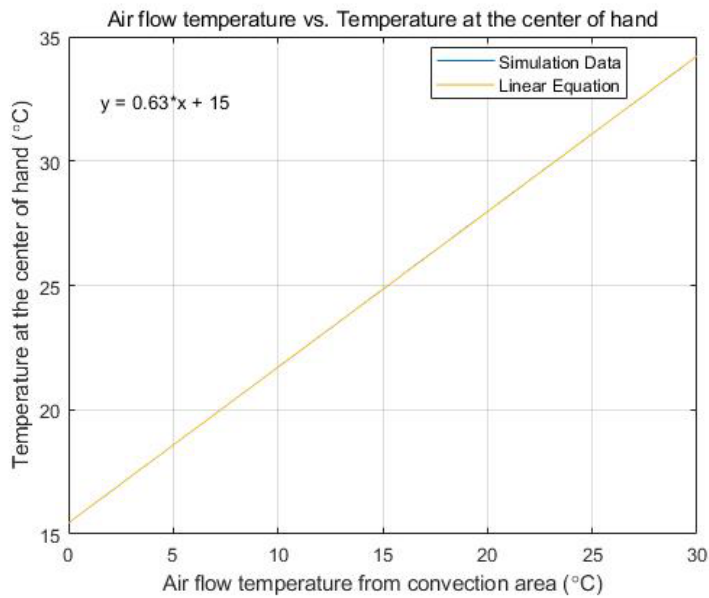
Figure 5. Air Flow Temperature vs. Temperature at the Center of the Hand. Table 1. Comparison between temperature at the center of hand with and without the air flow and CNT layer.